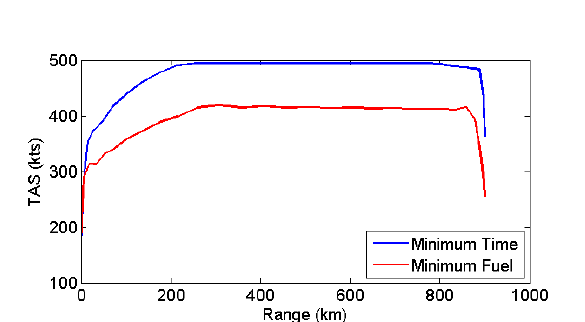
Fig. 6: True Airspeed profile for minimum time and minimum fuel burn.